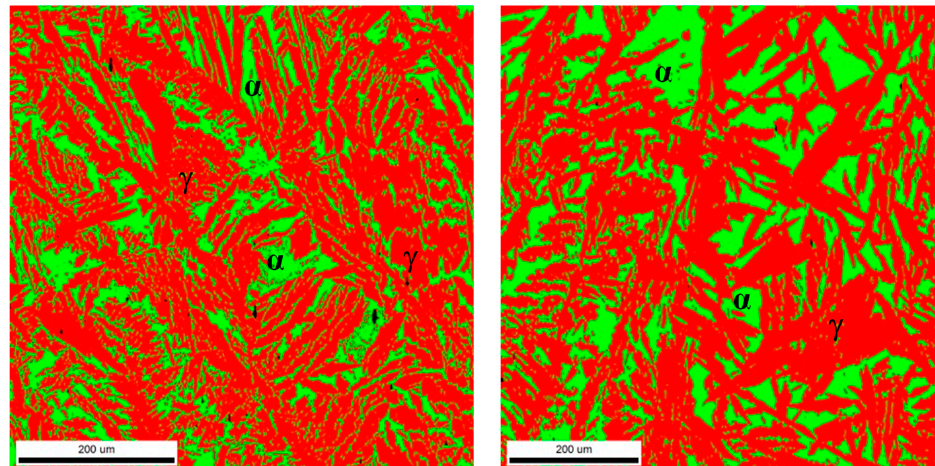
Figure 12. EBSD phase maps from Wall 1; ferrite is green, austenite is red.